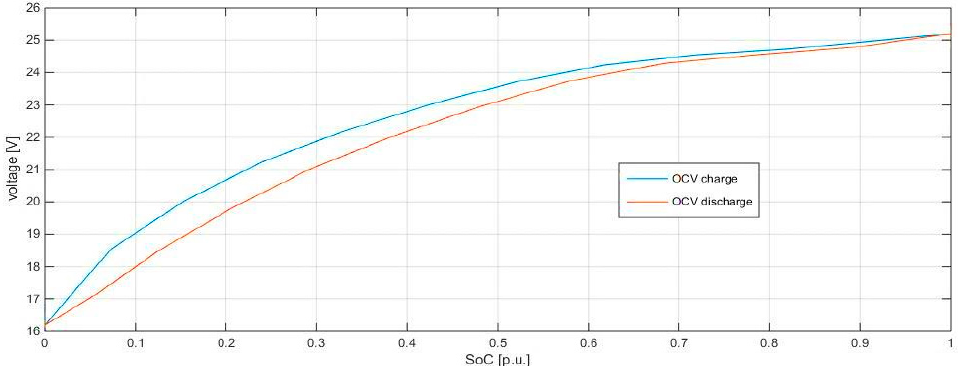
Figure 8. Open circuit voltage measured in the charging and discharging impulse test.